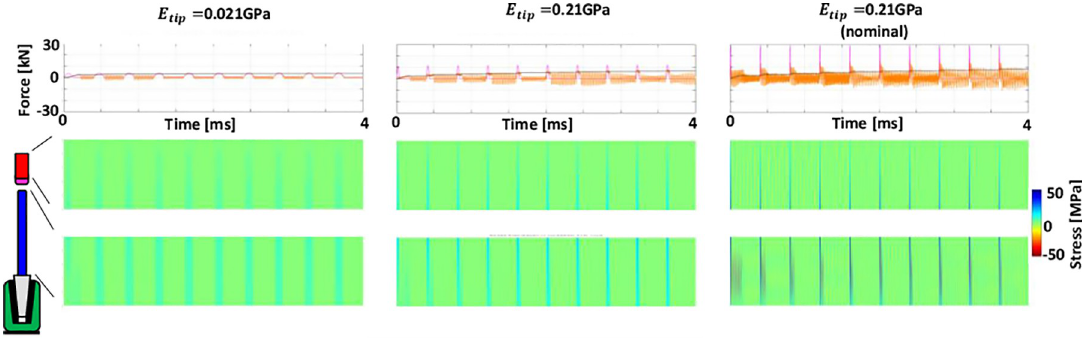
Fig 6. Note: Same colour-coding as Fig 3. Upper: Forces and stresses are shown for 10 consecutive hits, with hammer tip stiffness increasing from left to right. The right-hand plots ( E tip = 2.1GPa) are for nominal parameter magnitudes. Decreasing the tip stiffness towards the left decreases the peak impaction force and increases its period. This reduces the seating force and for the softest tip seating becomes non-progressive for consecutive impactions. Forces between the introducer and the implant become a smaller proportion of the impaction force and stresses in the introducer decrease. Note that these three cases can be visualised dynamically for the first hit in S1 File (above middle, nominal), S2 File (above left, 0.1xnominal), S3 File (above right, 10 × nominal).